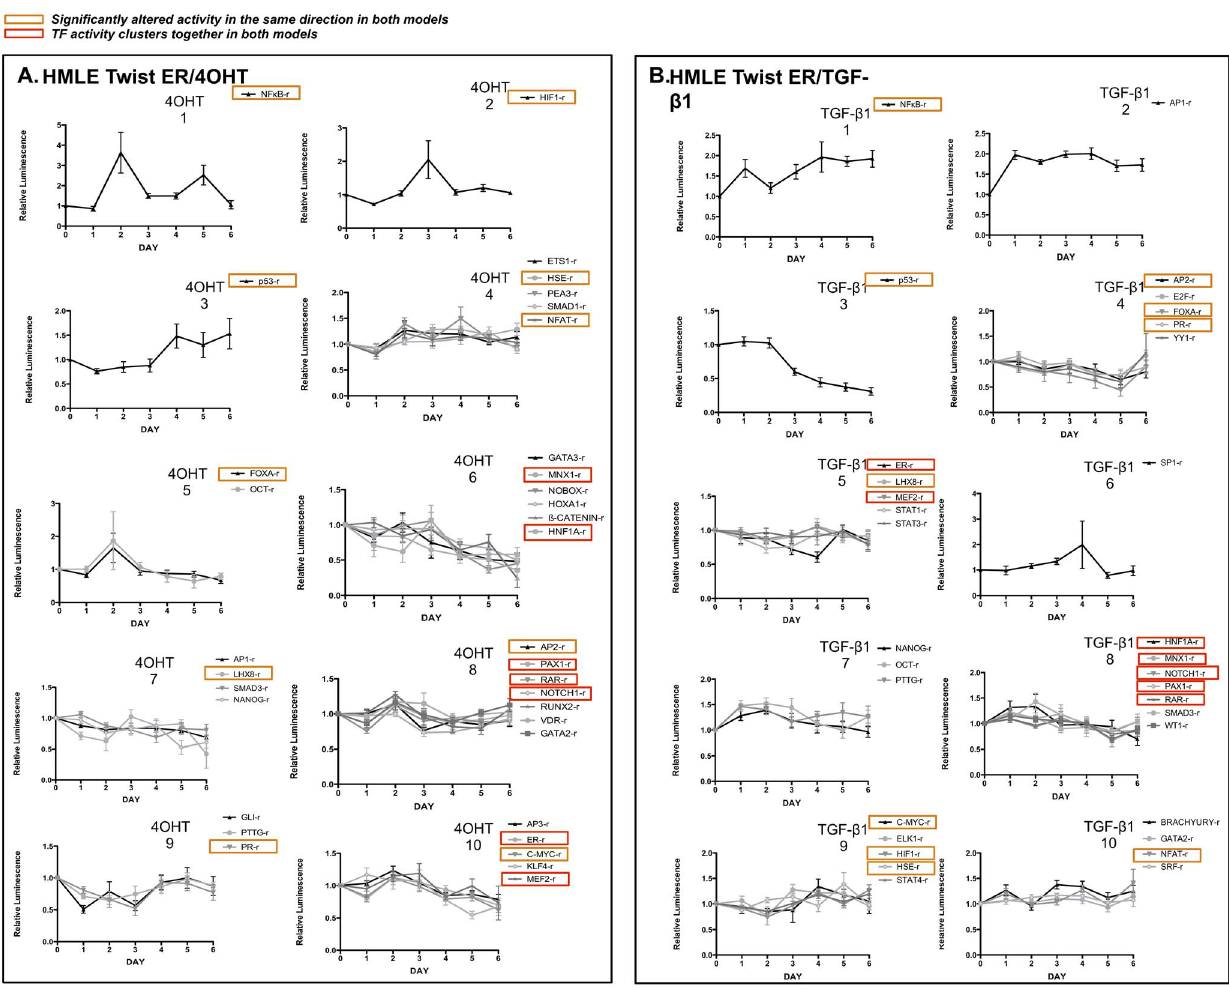
Figure 5. Cluster analysis of dynamic TF activity patterns. For each HMLE Twist ER model, significantly altered TF activities were clustered into ten groups with similar dynamics to identify groups of TF reporters with similar activation patterns during the six-day time course concurrent with loss of epithelial characteristics, upregulation of mesenchymal genes, and acquisition of an invasive phenotype as shown in Figures 1–3. A. Clusters of TFs in HMLE Twist ER cells treated with 4OHT. B. Clusters of TFs in HMLE Twist ER cells treated with TGF- b 1. Hierarchical clustering showing the relatedness of different groups is shown in Figure S1. Error bars indicate standard error of the mean.